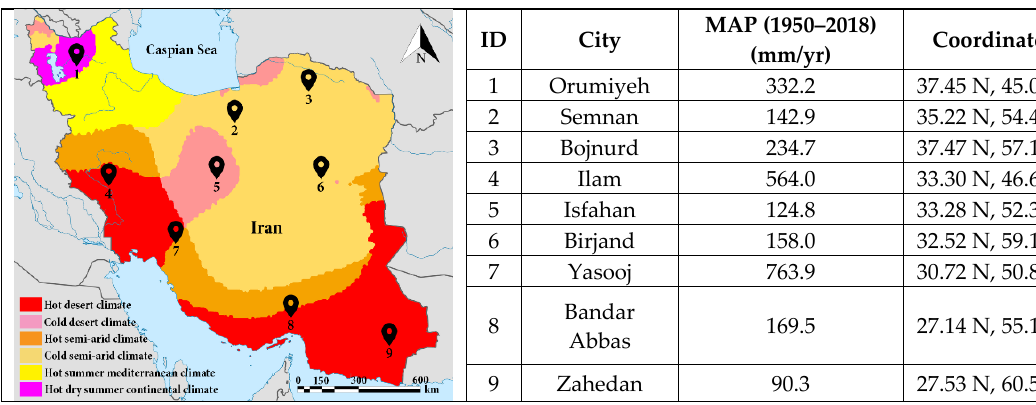
Figure 2. Selected stations in the study area [35].